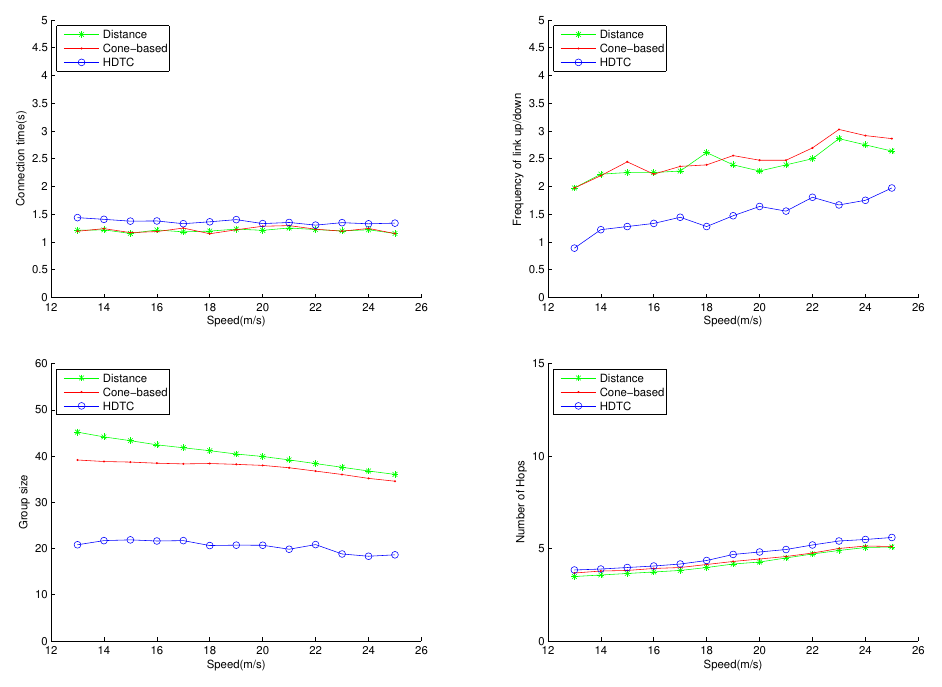
Figure 18. Scenario 3: The connection time, the frequency of the link up/down, the group size and the number of hops with varying the vehicle speed.